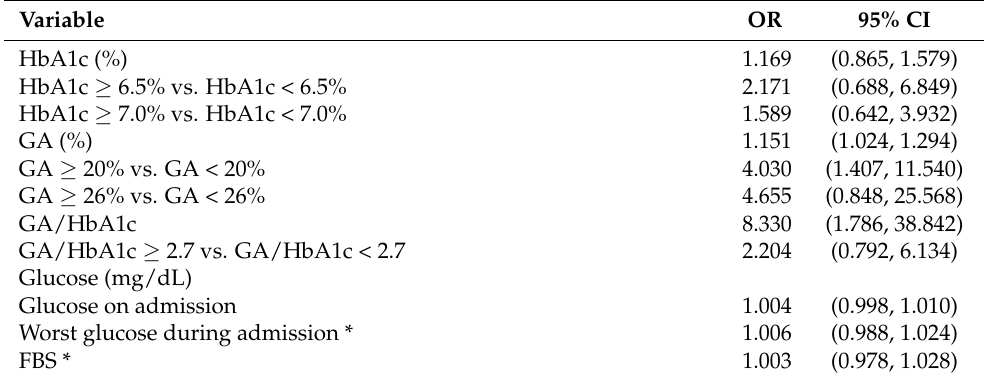
Table 4. Adjusted logistic regression of sugar control